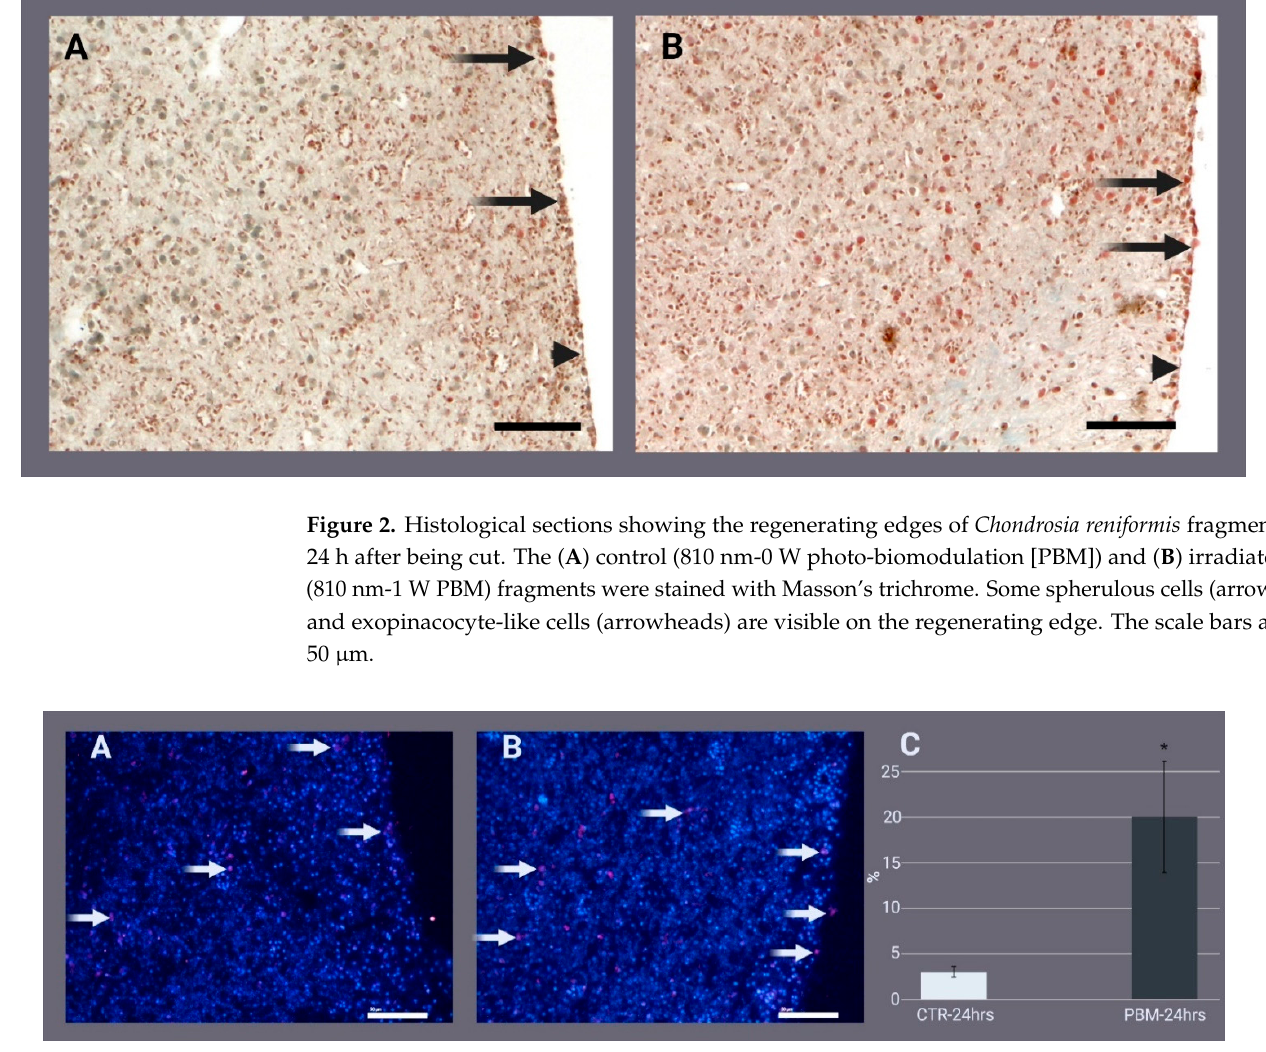
Figure 1. Effect of photo-biomodulation (PBM) on Chondrosia reniformis morphology during tissue regeneration. The regeneration profile of two C. reniformis specimens immediately (0 h) and 24, 72, and 120 h after being cut into four parts, daily irradiated on the regenerating edge with 810 nm-1 W PBM. PBM = samples irradiated with 810 nm-1 W PBM; control = samples irradiated with 810 nm-0 W PBM. Scale bars are 1 cm. The centre of the irradiated area is indicated by the red asterisk.